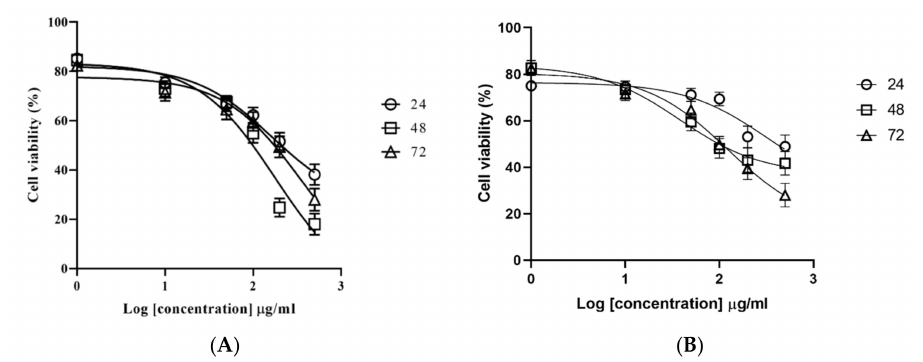
Figure 1. E ff ects of the M. fruticosa extract on the viability of ( A ) the mammary carcinoma F7 (MCF-7) and ( B ) human colon tumor (HCT-116) cells at 24, 48 and 72 h. Data from at least three independent experiments performed in at least triplicates are presented as the means ±